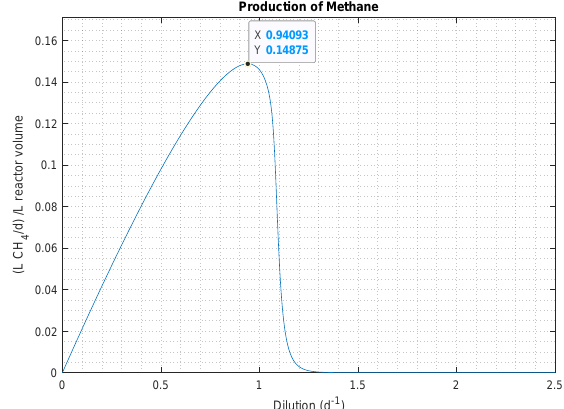
Figure 2: The steady state produced methane gas for dilution rates between 0 and 2.5 d − 1